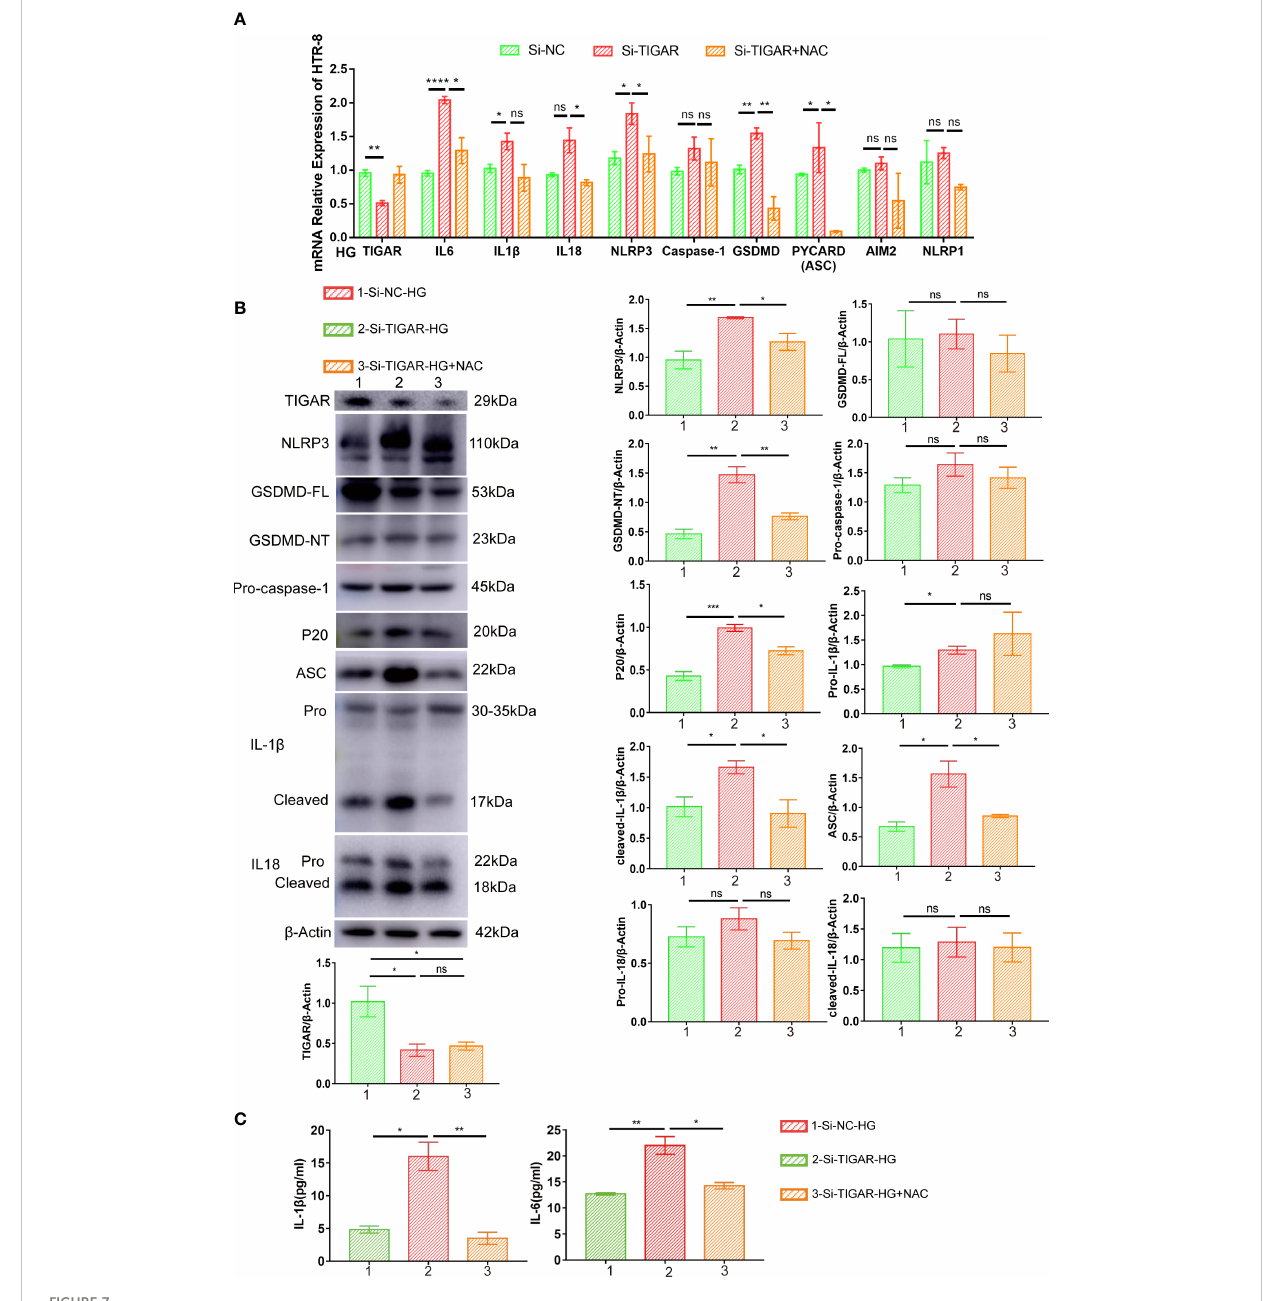
FIGURE 7 NAC alleviated pyroptosis induced by TIGAR knockdown in HG condition. The expression of proin fl ammatory cytokines (Pro-IL-1 b , cleaved-IL-1 b , IL18 and IL-6) and pyroptosis factors (NLRP3, ASC, GSDMD-FL, GSDMD-NT, Pro-caspase-1, P20) was evaluated by real-time PCR (A) and western blot (B) . b -actin were used as internal control. Bar graphs depict semi-quantitative analysis of protein expression levels. Dynamic changes of IL-1 b and IL-6 were assessed by ELISA. Data of the triple experiments are presented as the means ± SEM. *p < 0.05, **p < 0.01, ***p < 0.001, ****p < 0.0001 versus the indicated group, ns, no signi fi